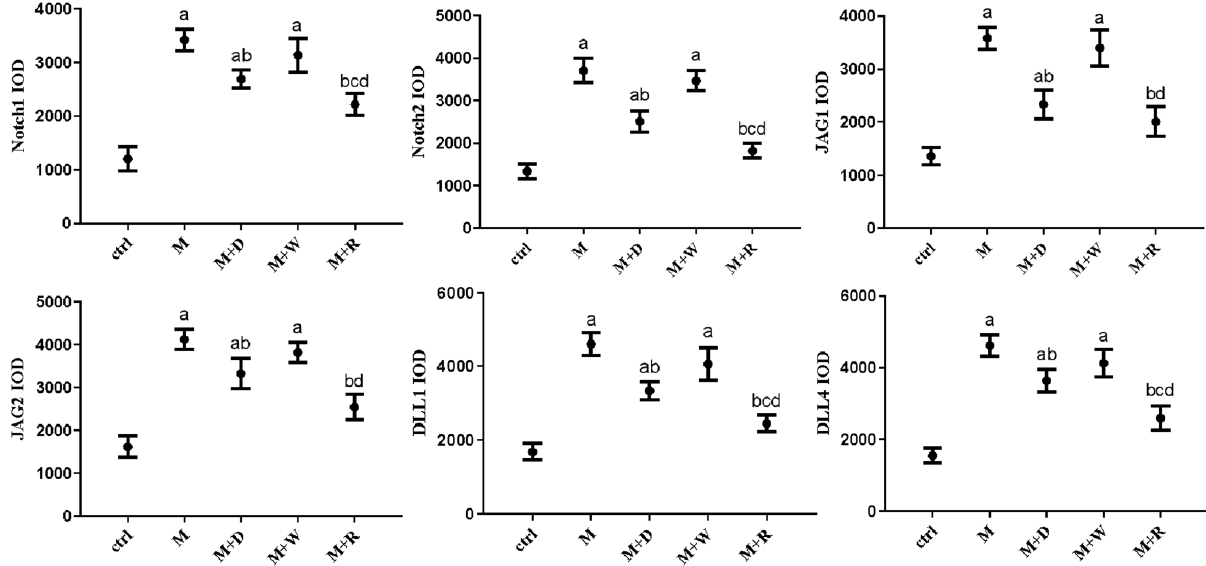
Figure 4: The expression levels of key proteins of the Notch pathway in the lung tissues of rats in each group: ( a ) statistically signi fi cant di ff erence from the Ctrl group ( P < 0.05 ) , ( b ) statistically signi fi cant di ff erence from the M group ( P < 0.05 ) , ( c ) statistically signi fi cant di ff erence from the M + D group ( P < 0.05 ) , and ( d ) statistically signi fi cant di ff erence from the M + R group ( P < 0.05 )